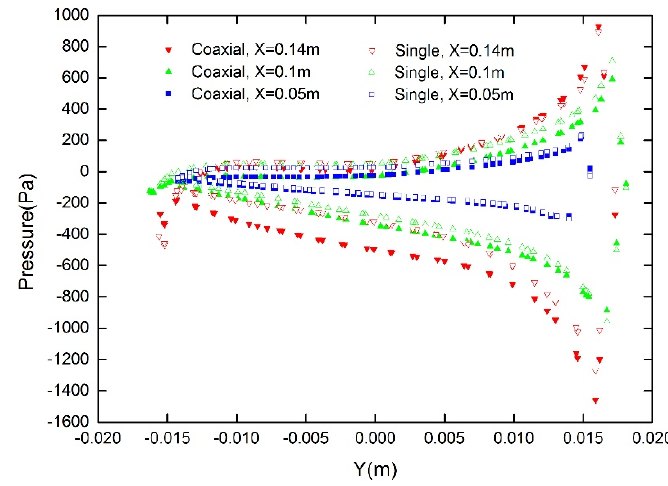
Figure 8. Calculated surface pressure of single and coaxial upper propellers.